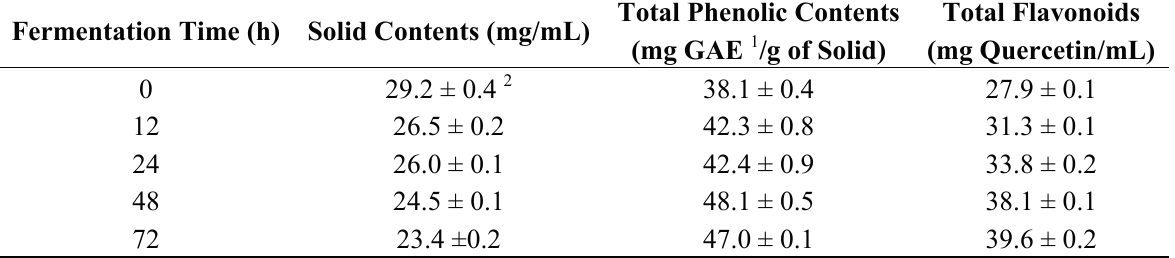
Table 1. Solid and total phenolic content of M. denudata extract fermented by P. acidilactici KCCM 11614.